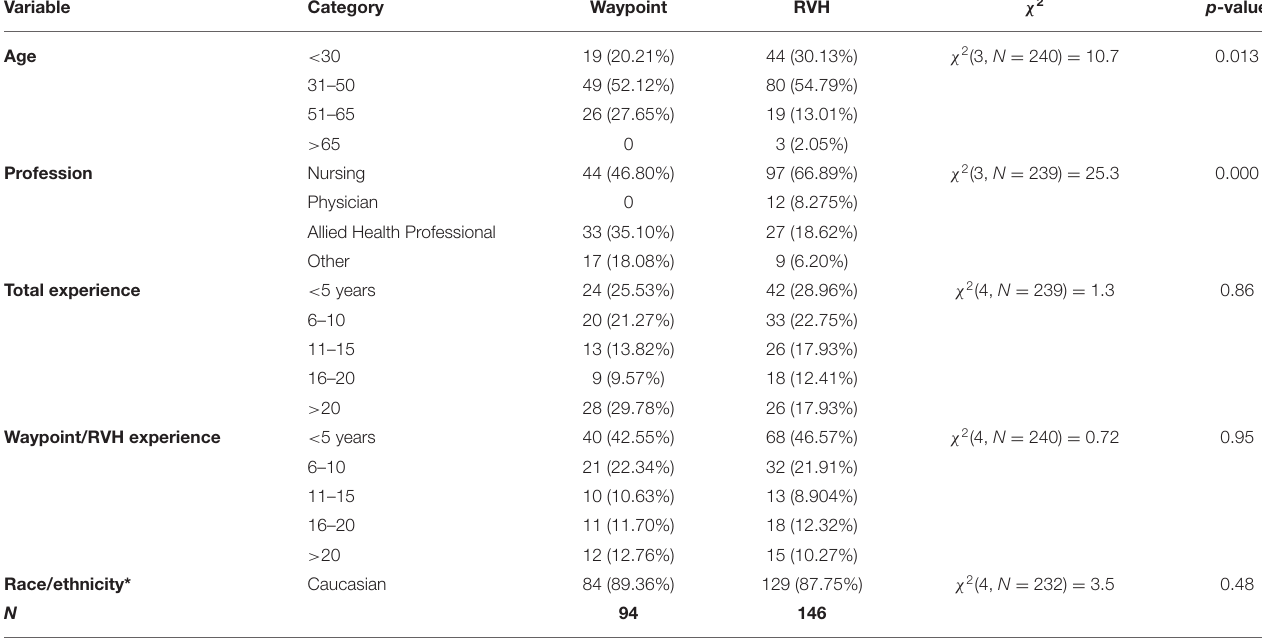
TABLE 1 | Demographics by site.